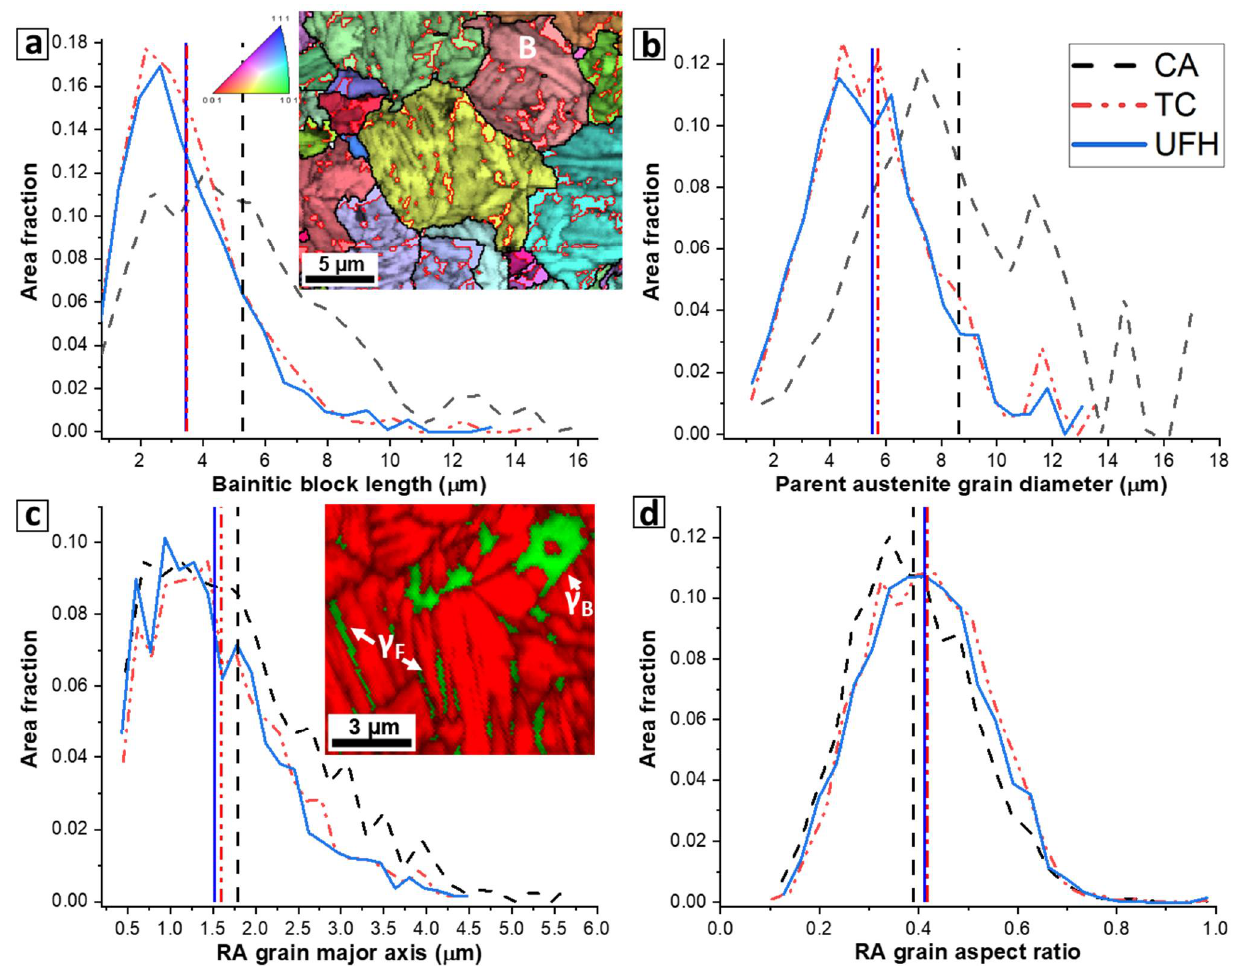
Figure 6. Grain size distribution: ( a ) bainitic block length. ( b ) reconstructed parent austenite grain size diameter. ( c ) retained austenite grain diameter. ( d ) retained austenite grain aspect ratio. Vertical lines denote the average value for each distribution. In ( a ), an IPF of reconstructed PAGs is presented together with the respective IQ map of the “child” bainitic blocks (B) formed after austempering for the CA sample. Retained austenite grains are enclosed by red boundaries. Film (γ F ) and blocky-like (γ B ) RA grains are highlighted in ( c ).